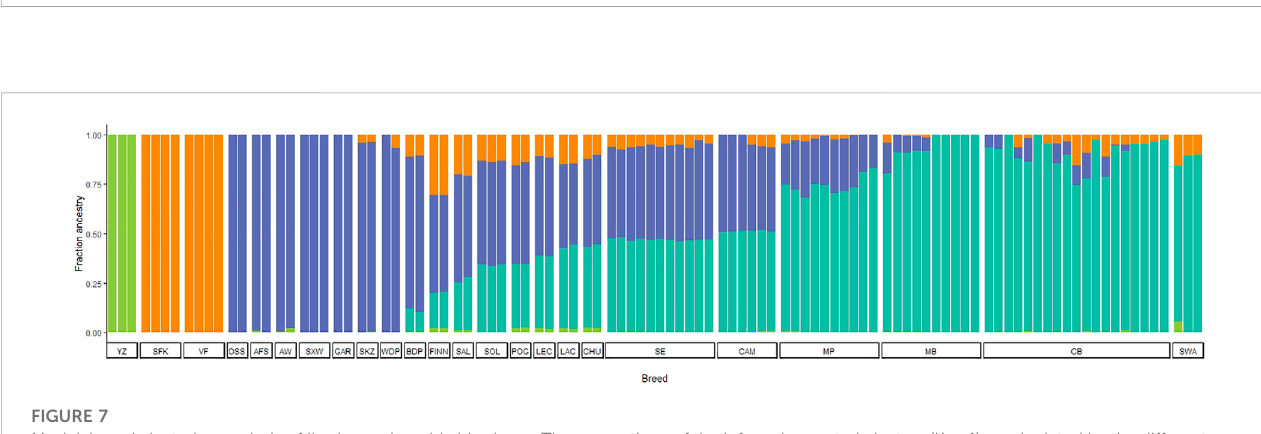
FIGURE 6 Principal component analysis (PCA) of Iberian sheep. PC1 and PC2 account for 10.5% and 7.69% of the total genomic variation, respectively. Portuguese sheep are represented by colouredtriangles, as follows: Campaniça in salmon; Merino Branco in golden brown; Merino Preto in blue; Serra da Estrela in pink; and Crossbreds in green. See Supplementary Table S3 for details on each individual included in the analysis.